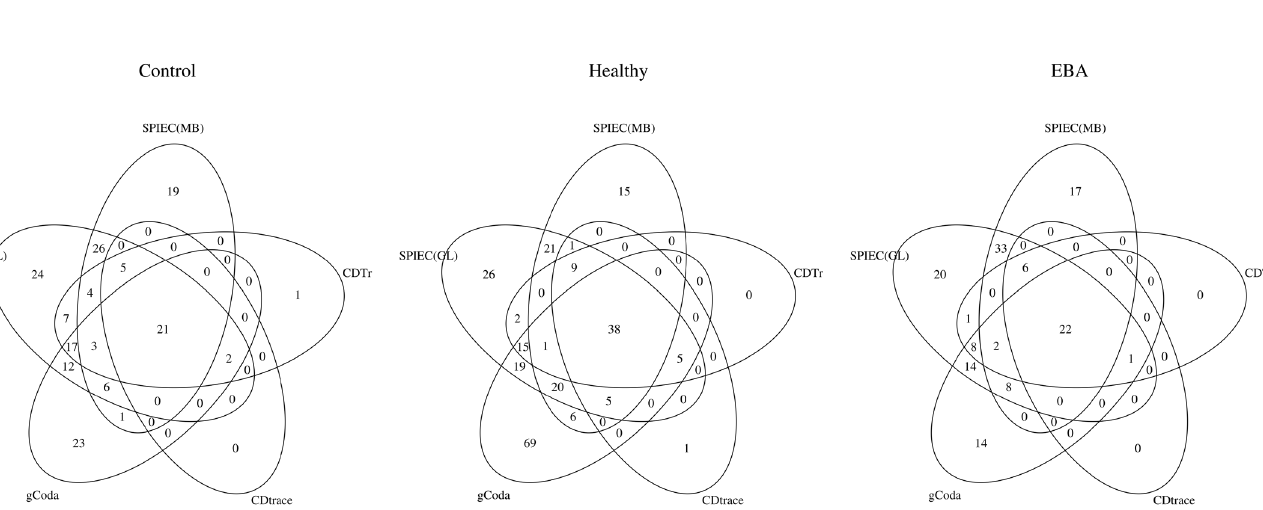
Fig 1. Venn diagrams of shared edges among direct interaction networks from various methods.